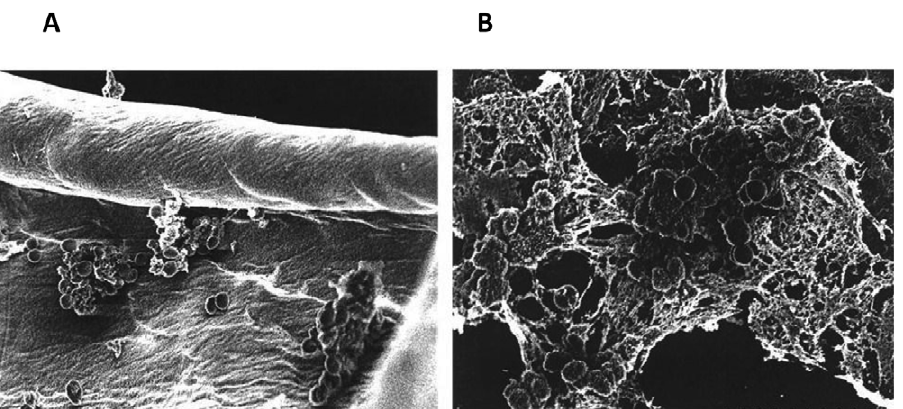
Figure 5. Community-associated Staphylococcusaureus 128 growing as biofilms on tampon fibers and cellulose acetate dialysis tubing. Staphylococcus aureus 128, a TSST-1 + organism at 10 7 /0.1 ml, was inoculated onto the inside of pre-wetted dialysis tubing that had been tied off on one end. A tampon was then inserted into the dialysis tubing and the tubing immersed under Todd Hewitt broth containing 0.8% agar. The open end of the dialysis tubing remained above the agar surface such that the only source of nutrients for the growing microbes was media absorbed across the dialysis tubing. Magnification of A was 6000x and B was 9000x. Both frames show organisms embedded in a complex matrix of extracellular material.